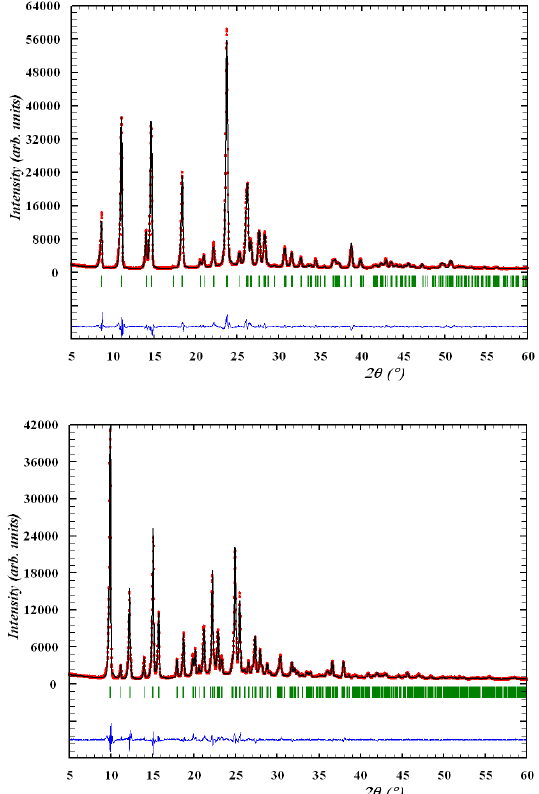
Figure 4. X-ray powder patterns of the monoclinic 2M ( top ) and orthorhombic 2M ( down ) forms of ester 2 and their Rietveld refinement: red —experimental X-ray diffraction patterns, black —calculated X-ray diffraction patterns, green —Bregg position of diffraction maximum, blue —difference between experimental and calculated intensity values in each point.